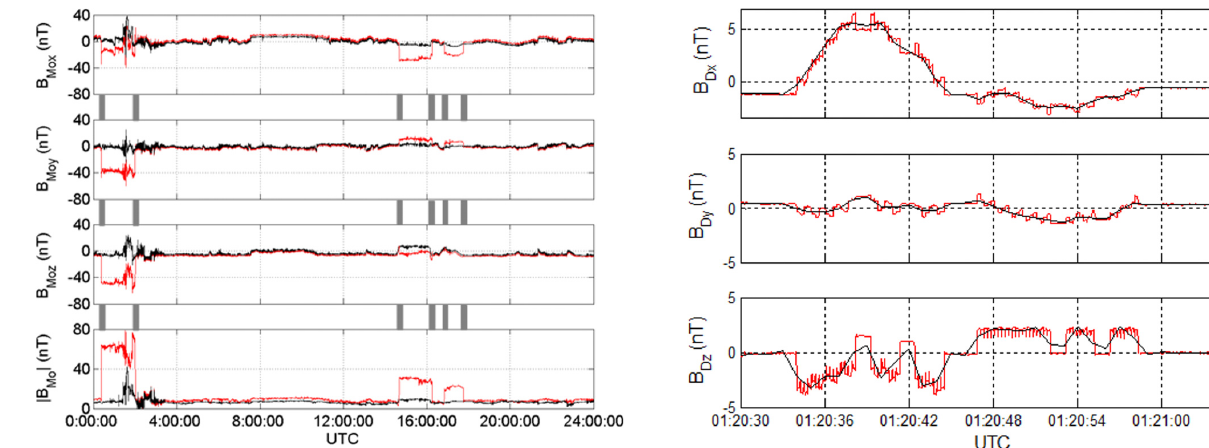
Fig. 7. A comparison of a VIRTIS associated event measured at 1Hz (black) and 32Hz (red) in the differenced data. The mean value of each field component has been removed to allow the rela- tive dynamic contribution in the two data sets to be